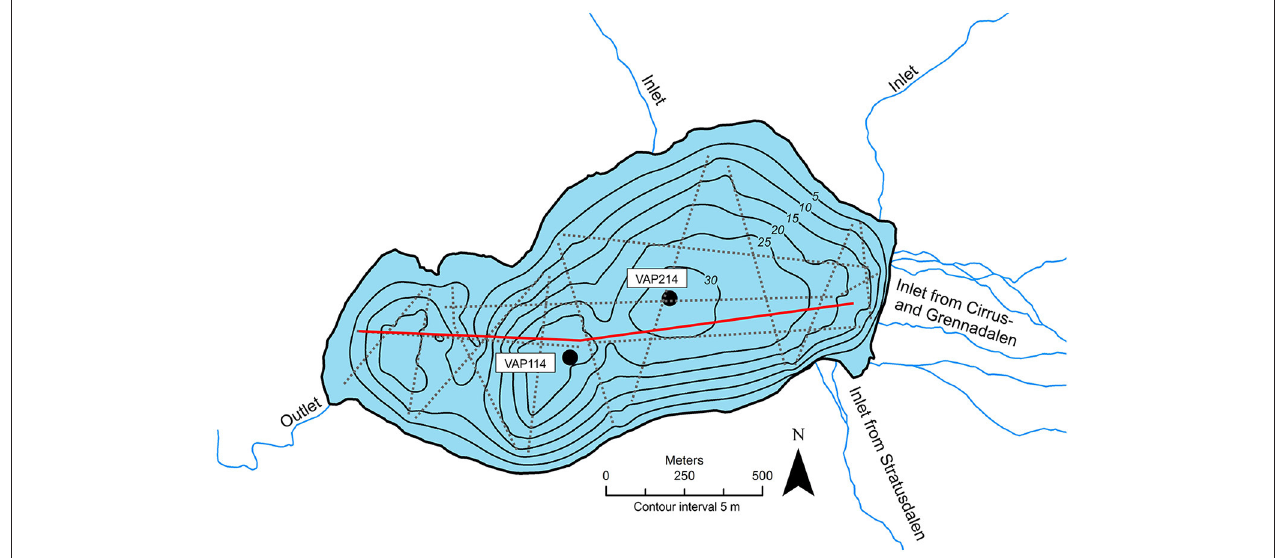
FIGURE 2 | Bathymetric map of Vårfluesjøen based on interpolation between GPR profiles ( n = 16 lines), indicated by gray stippled line, in the lake using ArcMap 10.2 software. Black dots mark the coring locations of VAP114 and VAP214. Red line indicates cross section line used to develop Figure 4